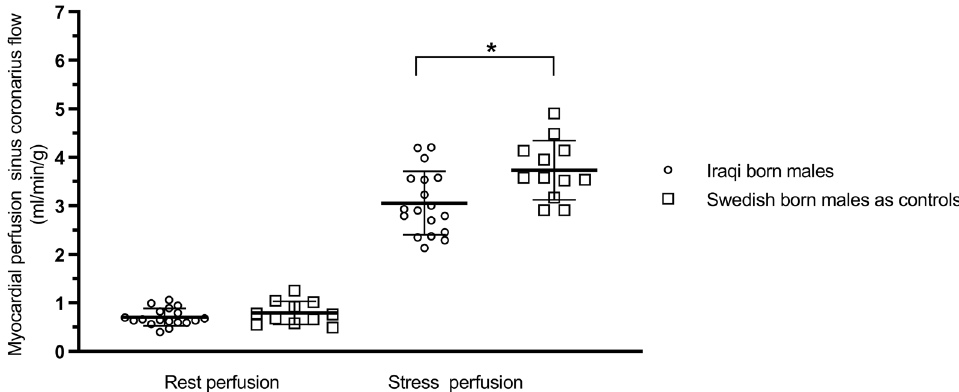
Figure 4. Global myocardial perfusion using sinus coronary flow analysis for Iraqi versus Swedish born males at rest and during adenosine. Myocardial perfusion during adenosine was significantly lower in Iraqi born men. Error bars denote mean ± SD.